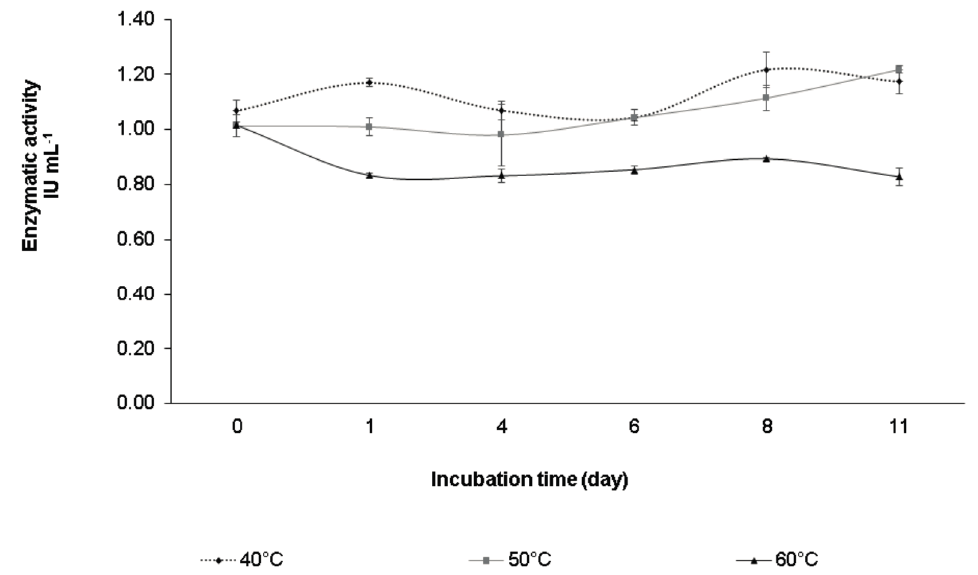
Figure 5. Thermostability profile of Man 58 at 40, 50 and 60